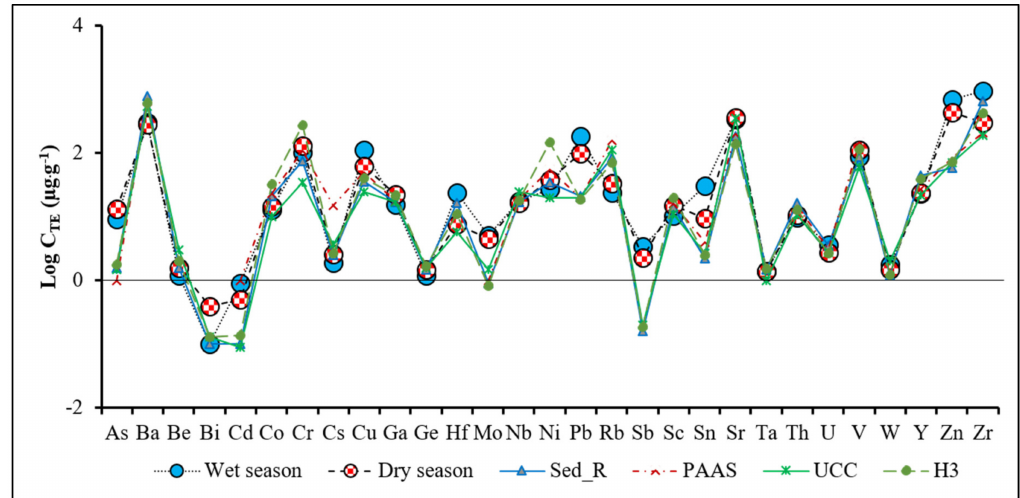
Figure 6. Average seasonal patterns of trace element (TE) concentrations in the Lom é lagoon sediments (means of nine site samples) during the dry and the wet seasons when compared with the PAAS, UCC, and the local reference materials, Sed_R and H3. See Table S3 for the average TE concentrations and Table S4 for TE concentrations for each site and each season.